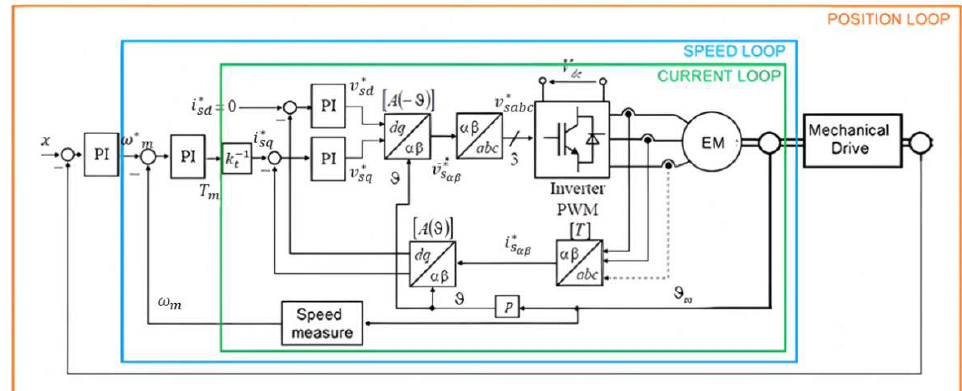
Figure 3. Architecture of the case study.